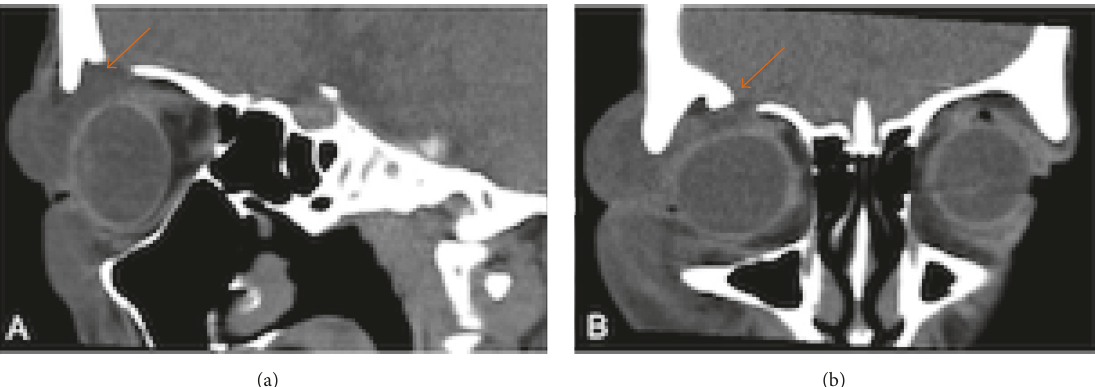
Figure 2: Orbital CT scans ((a) sagittal scan, (b) coronal scan) revealed an area of bone discontinuity in the right orbital roof with adjacent cephalocele (arrow).